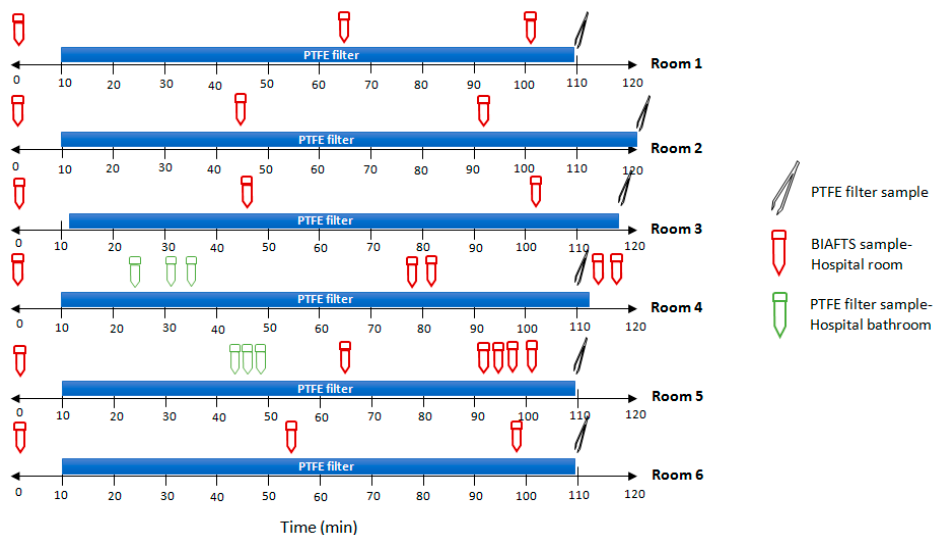
Figure 4. Samples collection timeline of hospital rooms tests. Air samples from COVID-19 hospital rooms were taken in a 2-h time interval. SARS-CoV-2-containing aerosols from six different rooms were sampled using PTFE filters and BIAFTS. PTFE filters samples were taken for 105–120 min, and BIAFTS samples were taken in 2 min at different times in the same time interval. Blue bars indicate the duration of PTFE filtration process; red falcon symbols-BIAFTS samples taken in the hospital room; and green falcon symbols-BIAFTS samples taken in the bathroom of the corresponding hospital room. Each hospital room was occupied by two COVID-19 patients.